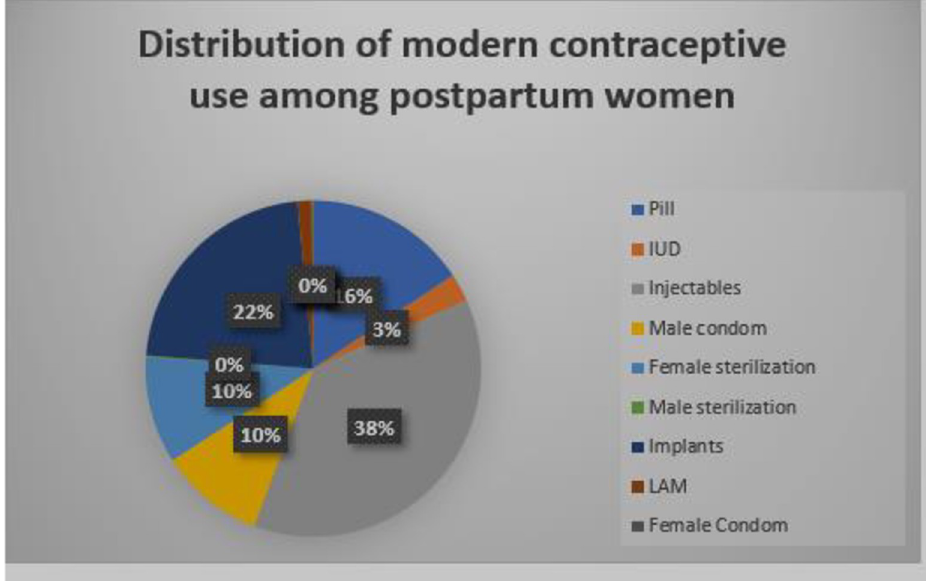
Fig 3. Distribution of modern contraceptive use among postpartum